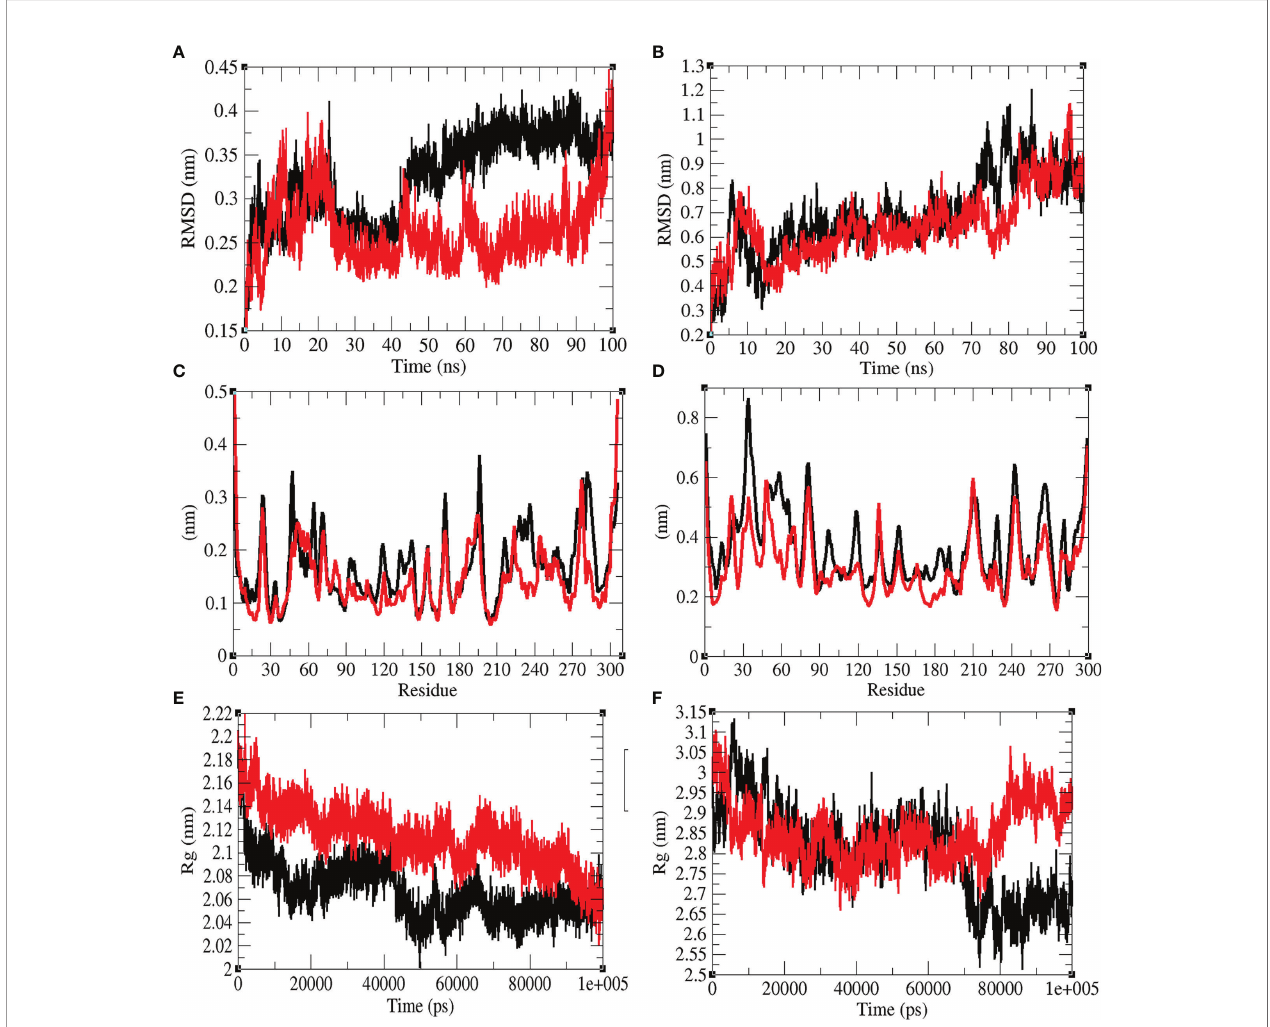
FIGURE 3 | Structural dynamics. (A) RMSD plot for Mprotease (black) and Mprotease-psilacetin (red) vs. time. (B) RMSD plot for HIK6 (black) and HIK6- psilacetin (red) vs. time. (C) RMSF vs. residues for Mprotease (black) and Mprotease-psilacetin (red). (D) RMSF fl uctuations vs. residues for HIK6 (black) and HIK6- psilacetin (red). (E) Radius of gyration (Rg) plot for Mprotease (black) and Mprotease-psilacetin (red). (F) Radius of gyration (Rg) plot for HIK6 (black) and HIK6-psilacetin